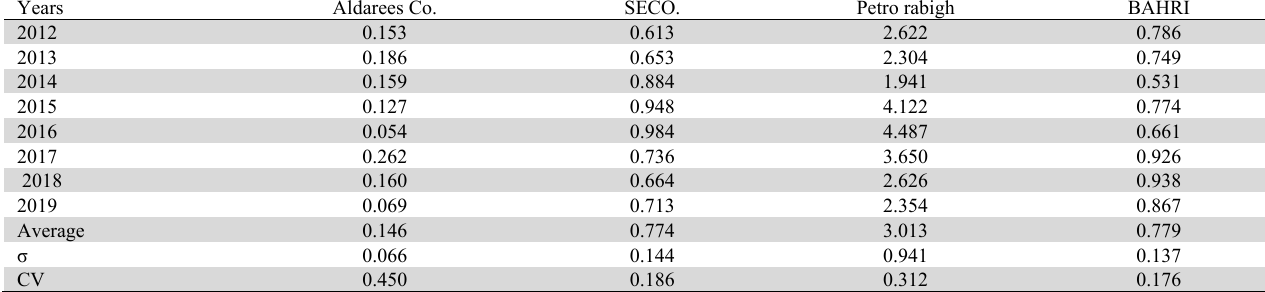
Long-term paying ability (Debt-equity Ratio) of the energy sector companies of Saudi Arabia Years Aldarees